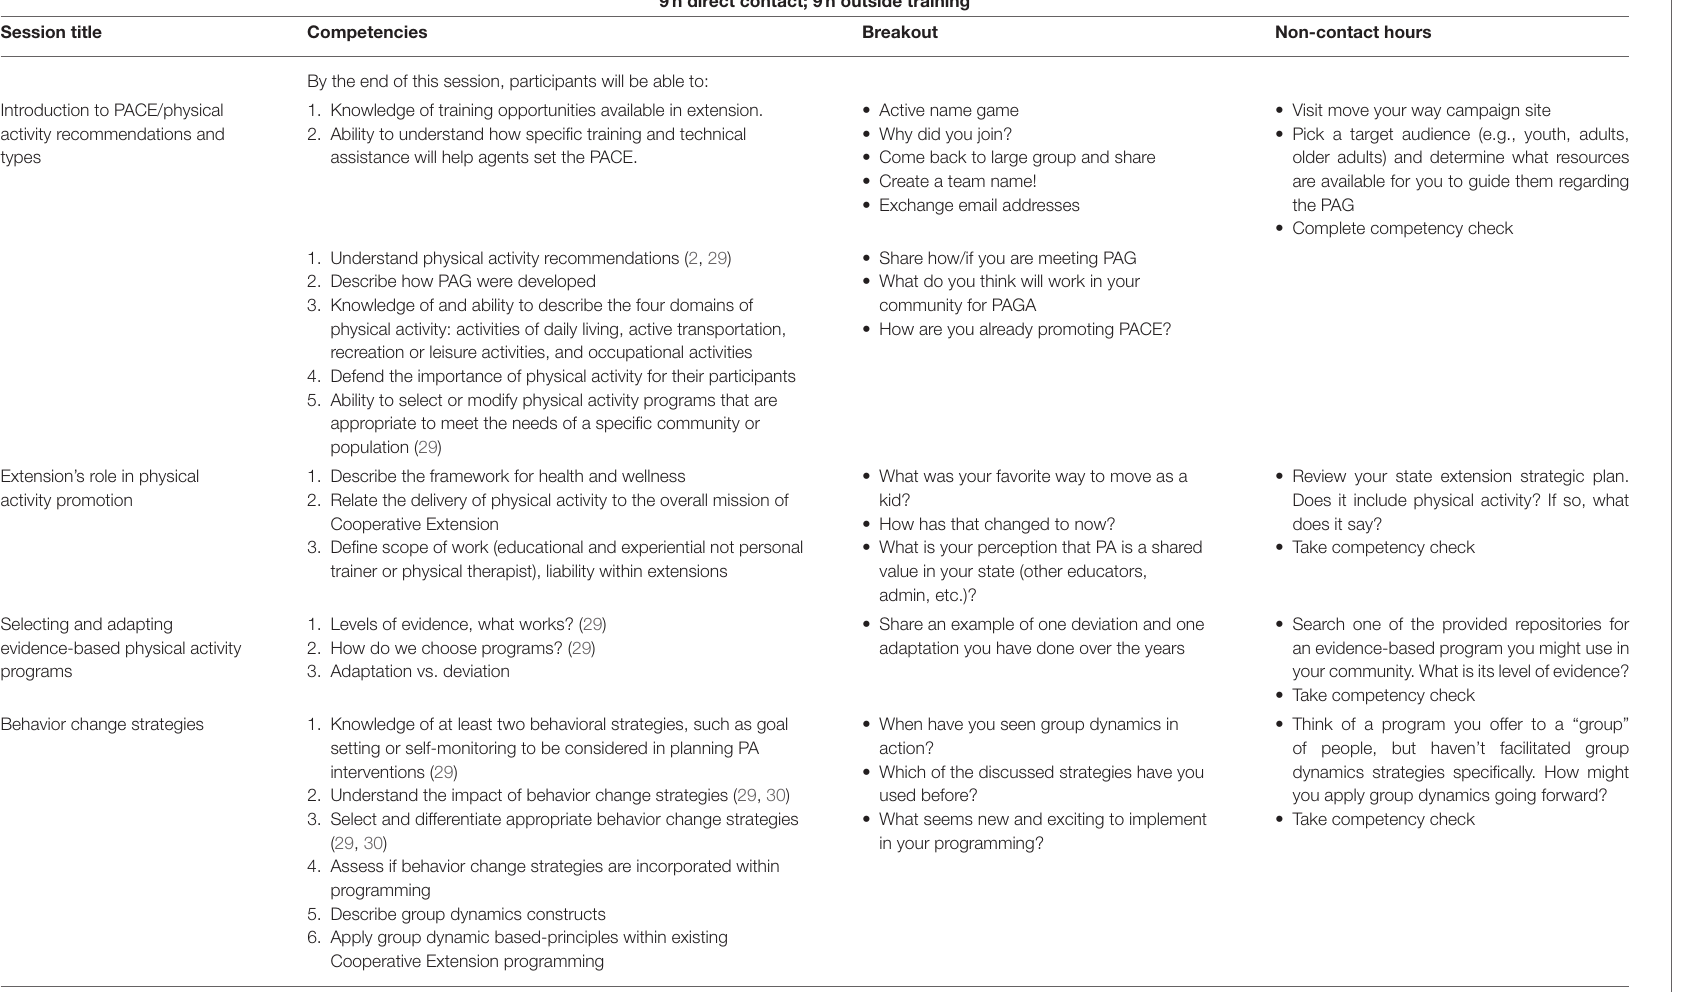
TABLE 1 | Outline for physical activity in Cooperative Extension: Let’s set the